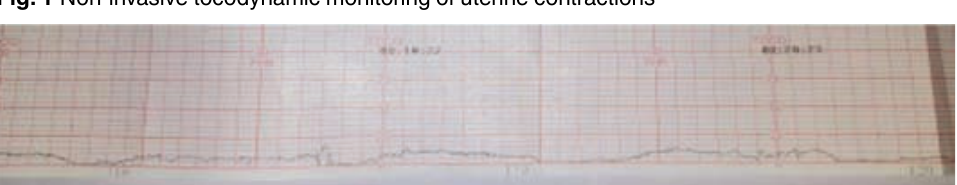
Fig. 1 Non-invasive tocodynamic monitoring of uterine contractions